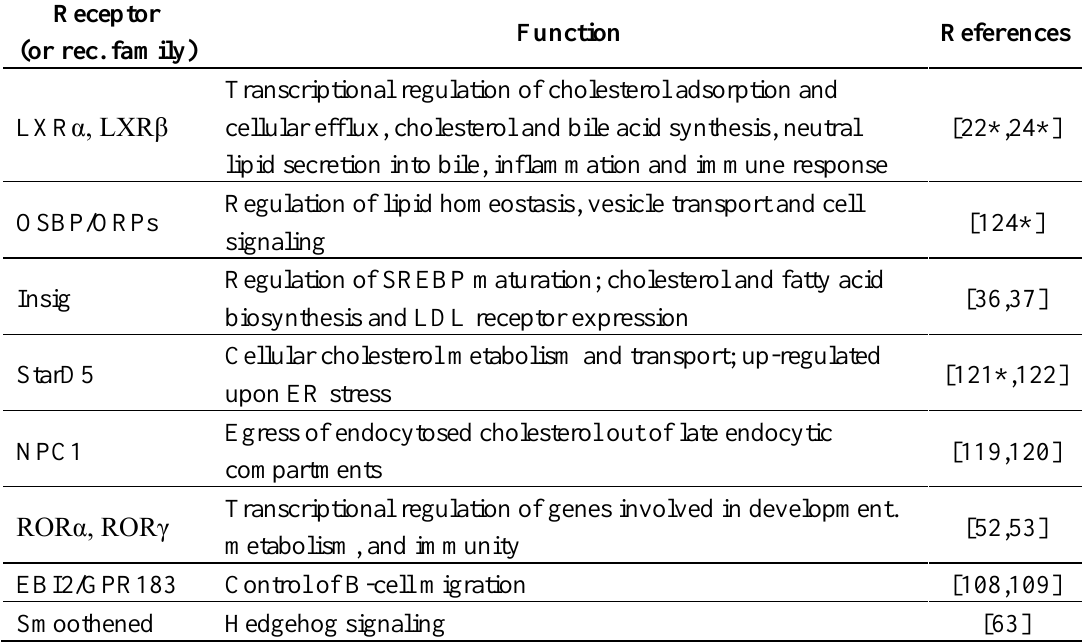
Table 2. Cellular receptors for